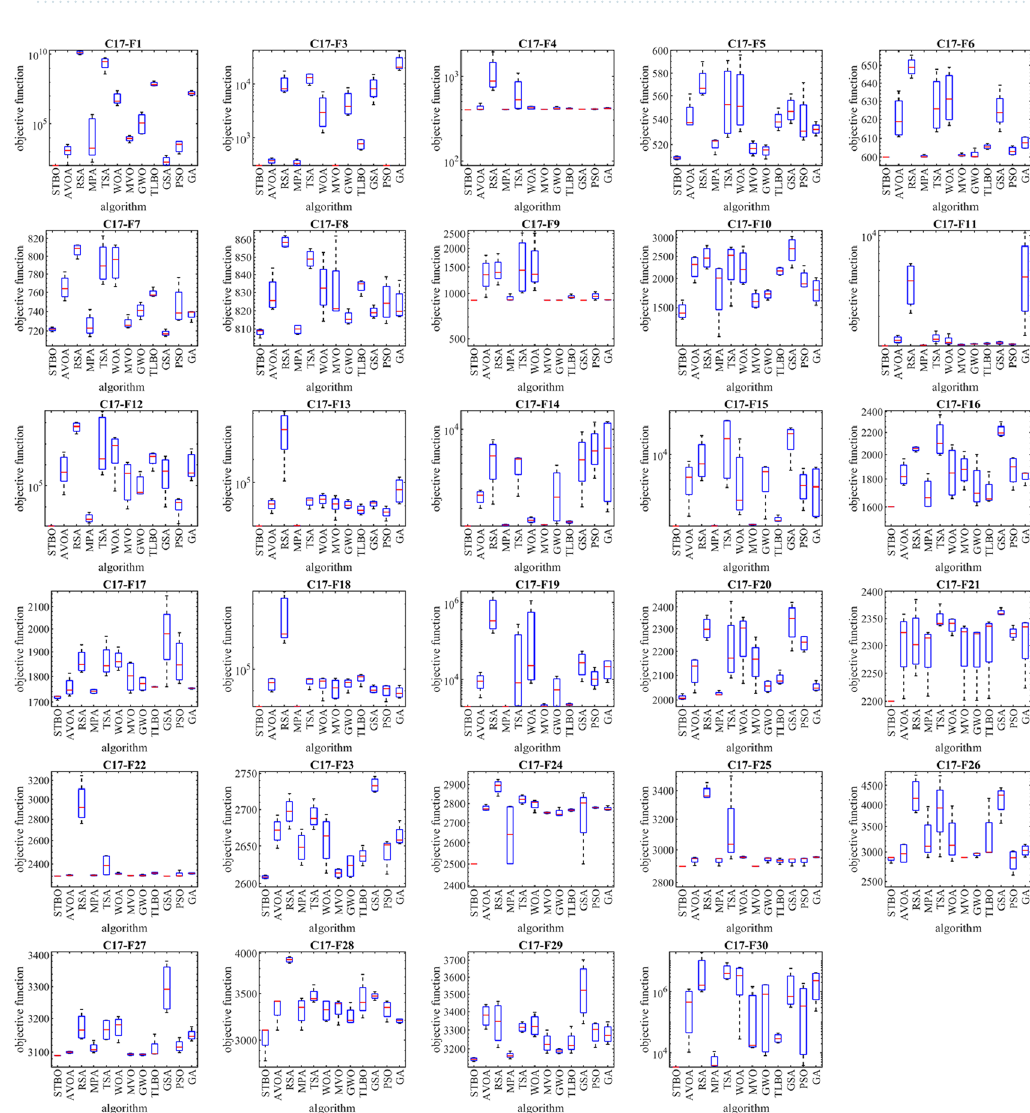
Figure 3. Boxplot of performance of STBO and competitor algorithms in solving the CEC 2017 test